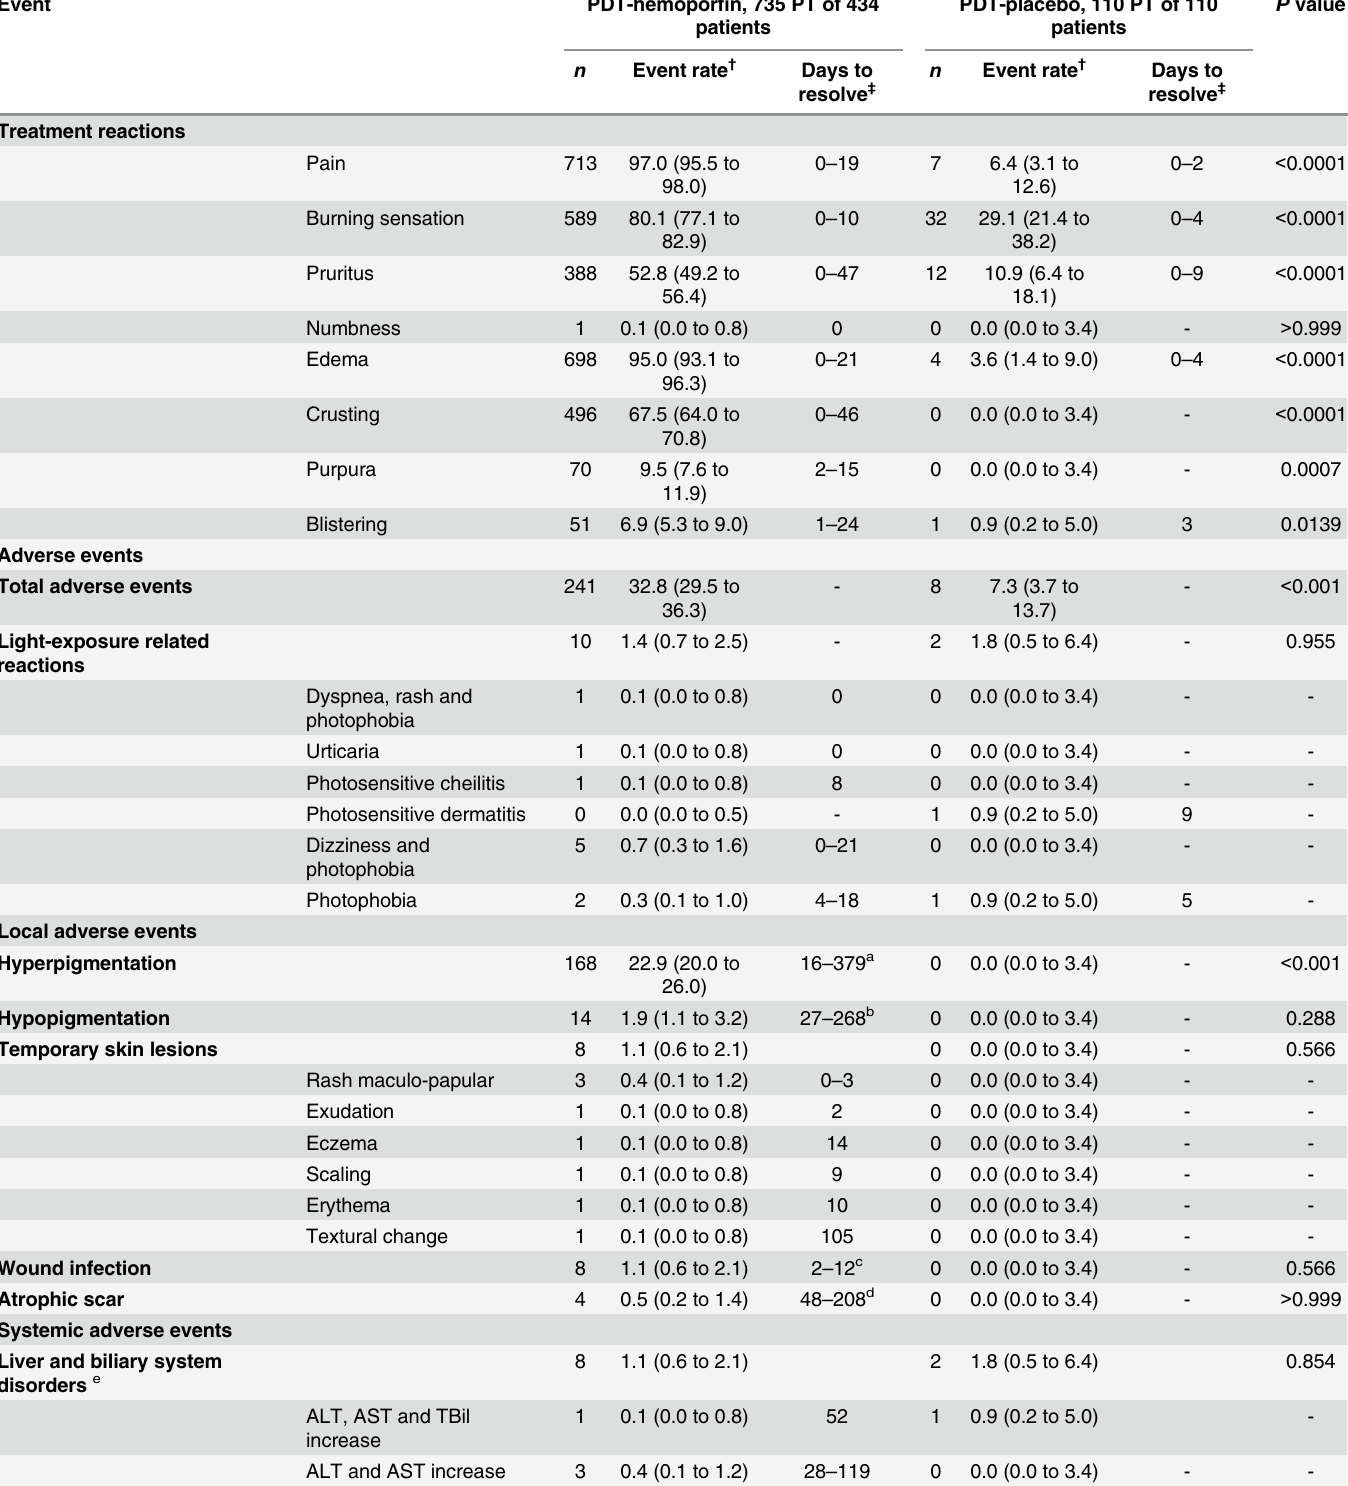
Table 4. Treatment reactions and adverse events possibly related to the